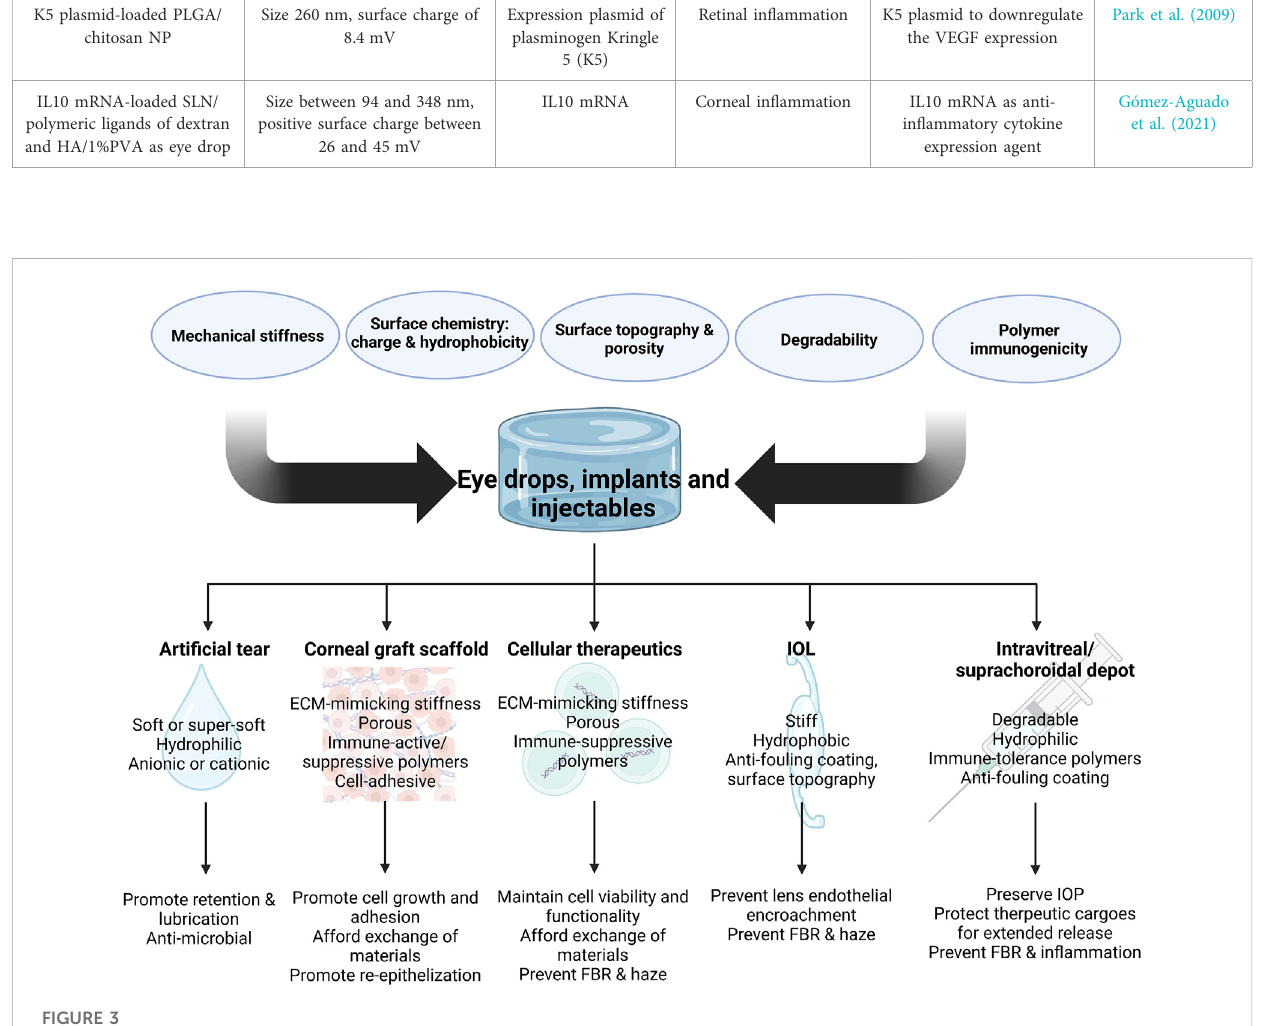
Design parameters of implants and injectable depots for various ocular applications and key features for desired therapeutic outcomes (Created in